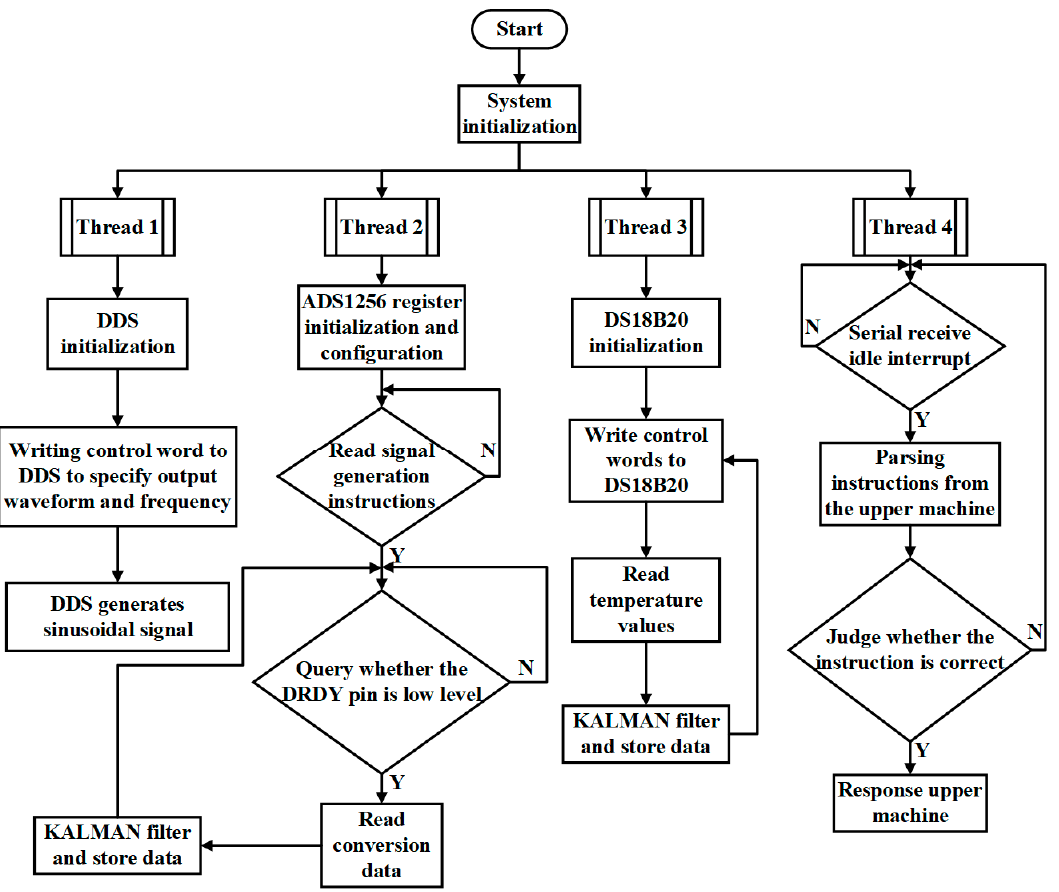
Figure 14. Software design flow chart of lower machine.